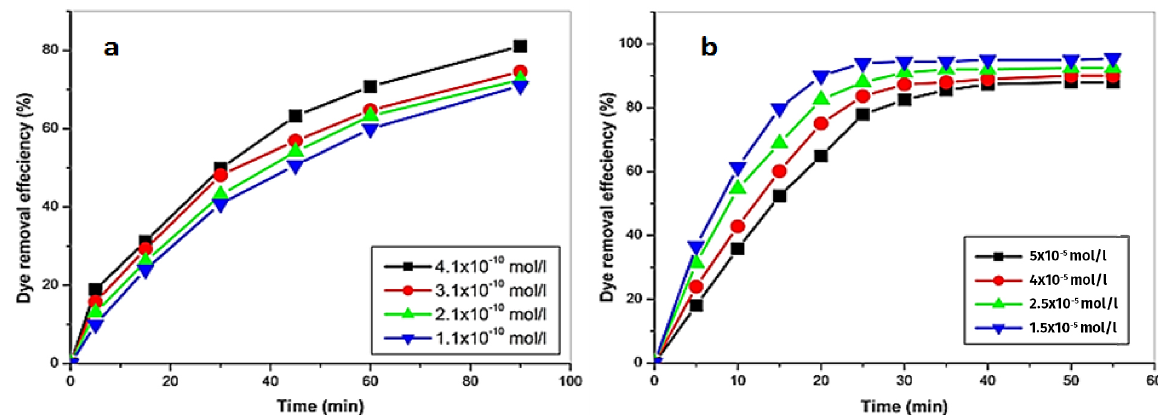
Figure 3. (a) Efficiency (%) of S. paucimobilis TiO o C, (b) Efficiency (%) of MG concentrations on the removal process using S. paucimobilis TiO